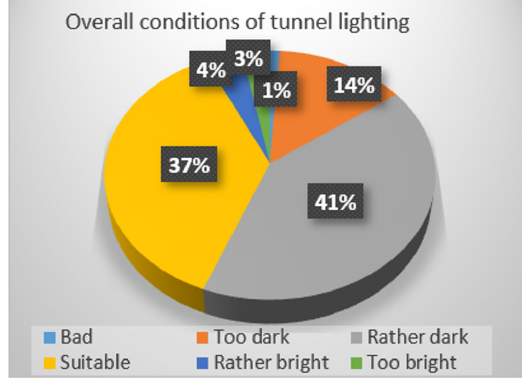
Figure 2. Overall conditions of tunnel lighting.